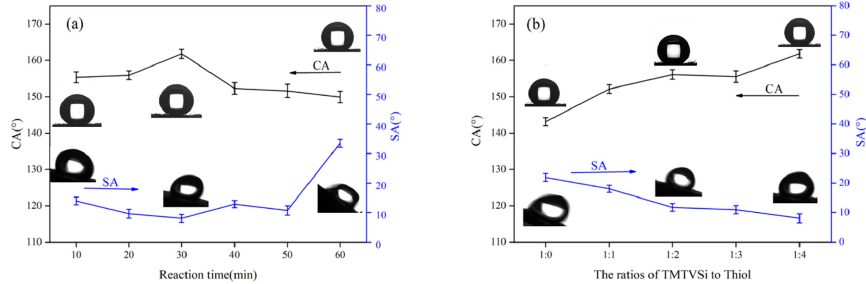
Figure 2. CA and SA changes with reaction time ( a ) and the ratios of TMTVSi to Octadecyl mercaptan ( b